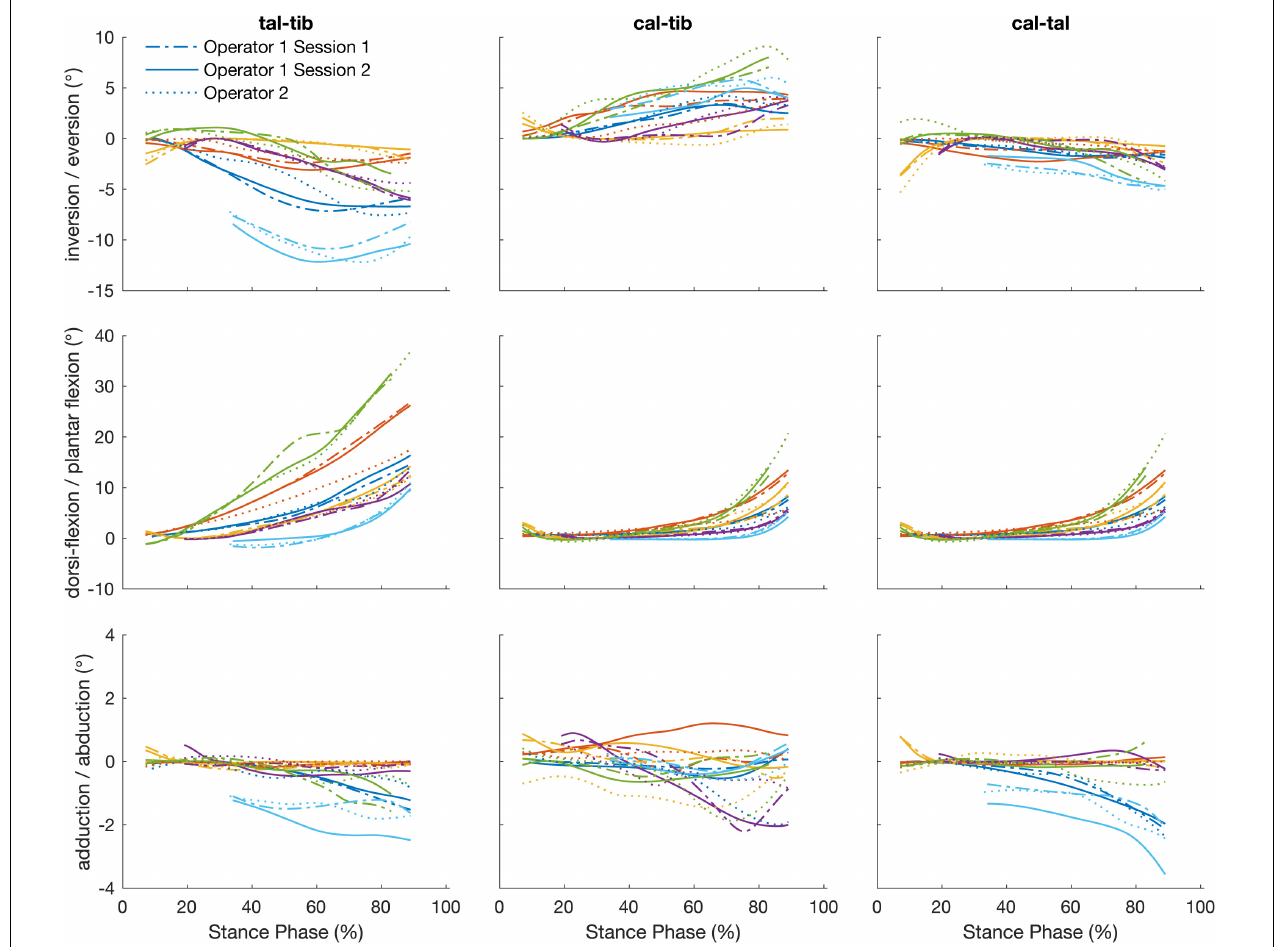
FIGURE 5 | Plots illustrate time normalized kinematics of the talus relative to the tibia (talus-tibia) and calcaneus relative to the tibia (calcaneus-tibia) and talus (calcaneus -talus) of each participant tracked by a single operator over two sessions, session 1 (dash line) and session 2 (solid line) and operator two (dotted line).